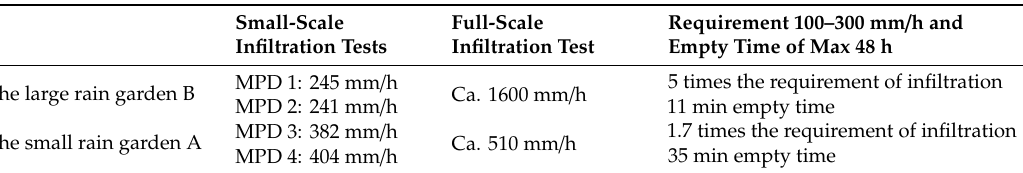
Figure 9. MPD infiltration tests where MPD 3 and 4 were measured in the smaller compartment A (picture on the left) and MPD 1 and 2 were measured in the larger compartment B (picture on the right). Photo: Torstein Dalen, Bergen Municipality.